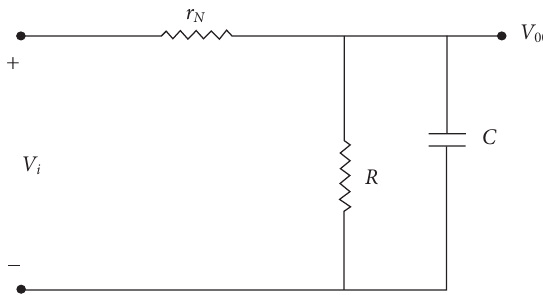
Figure 3.3. Zeroth-order perturbation model for diode in half-wave